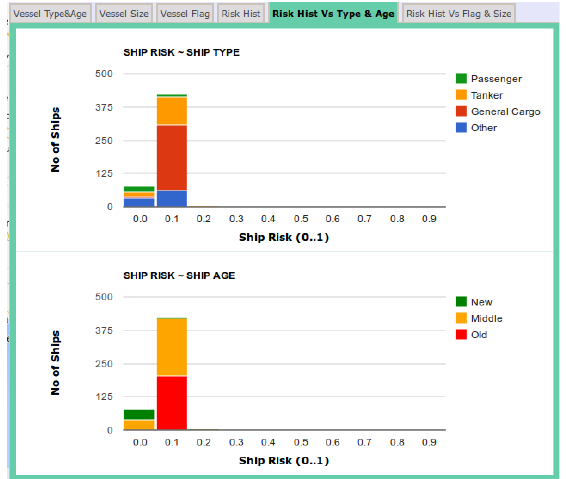
Figure 3: Example of Risk Histogram per ShipType and per ShipAge